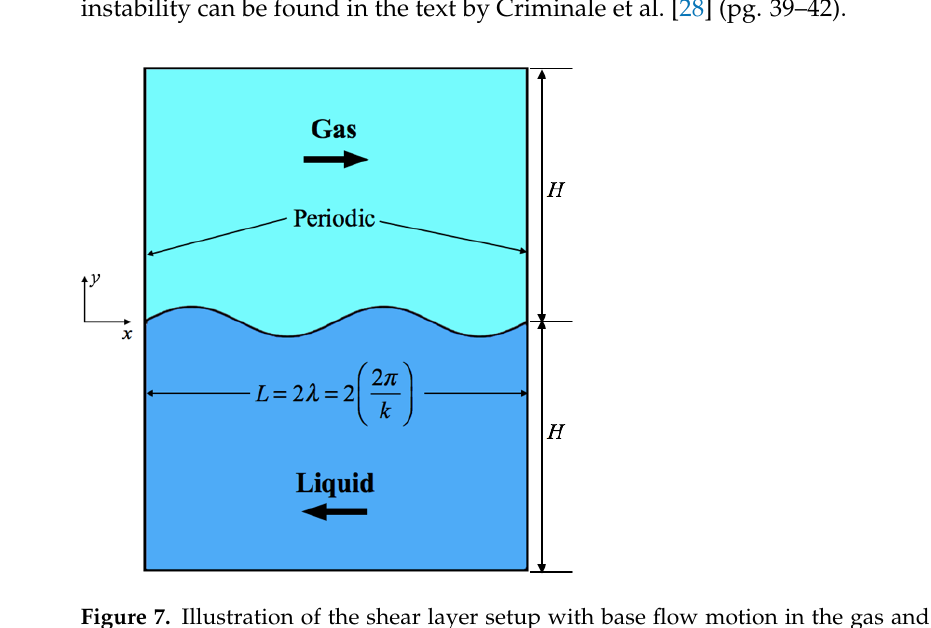
Figure 7. Illustration of the shear layer setup with base flow motion in the gas and liquid phase regions in opposite directions and with an imposed perturbation on the gas–liquid